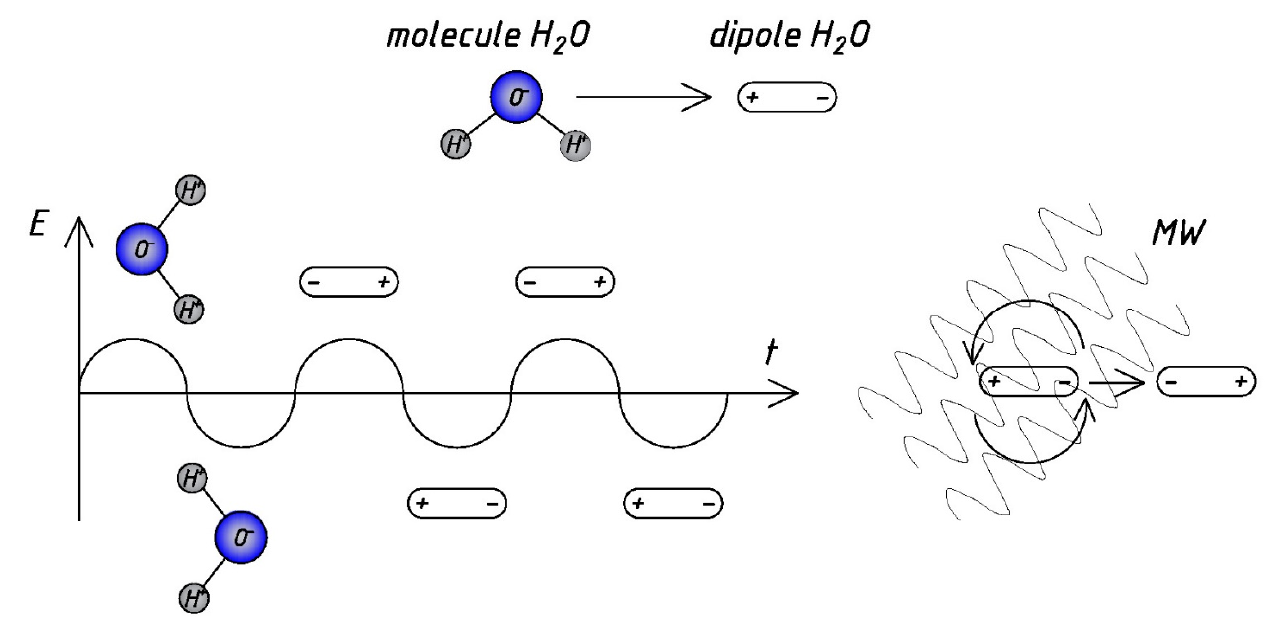
Figure 1. The scheme of mechanism of the MW water heating.